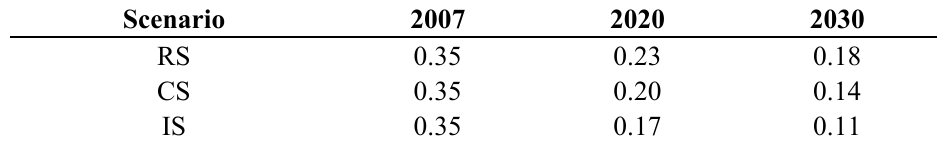
Table 7. Carbon emission intensity under the three scenarios (units: t-C/10,000